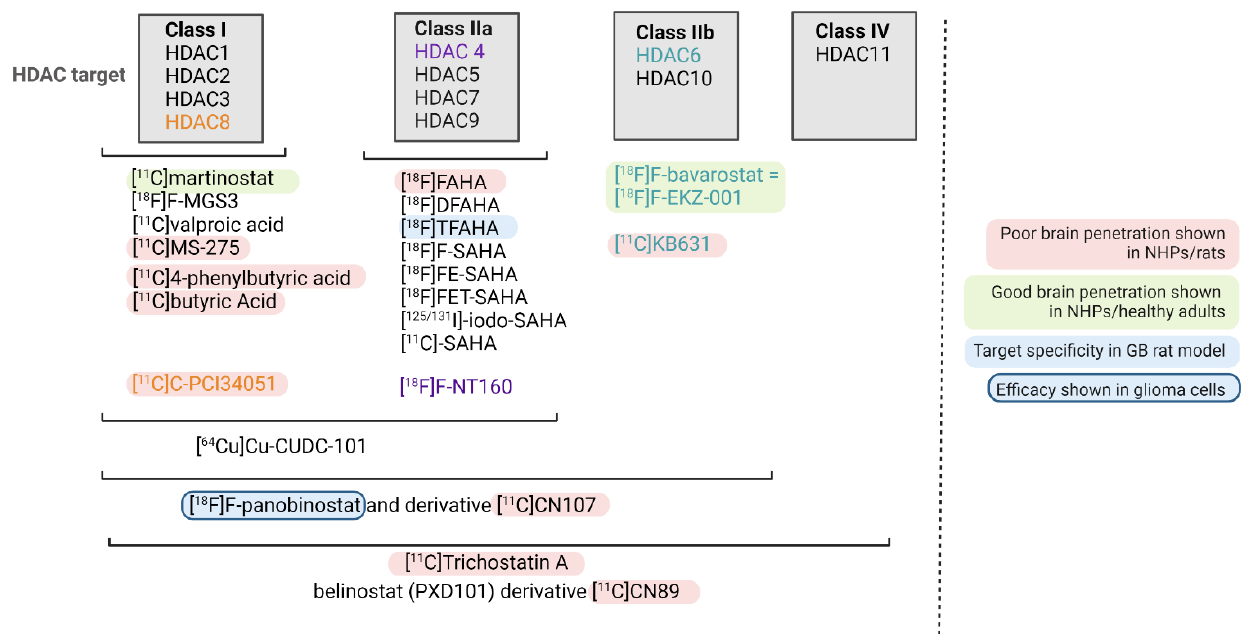
Figure 2. Overview of current radiopharmaceuticals targeting HDAC. The HDAC class targeted is shown. If only one HDAC enzyme is targeted, this was highlighted in color (orange, purple and green).